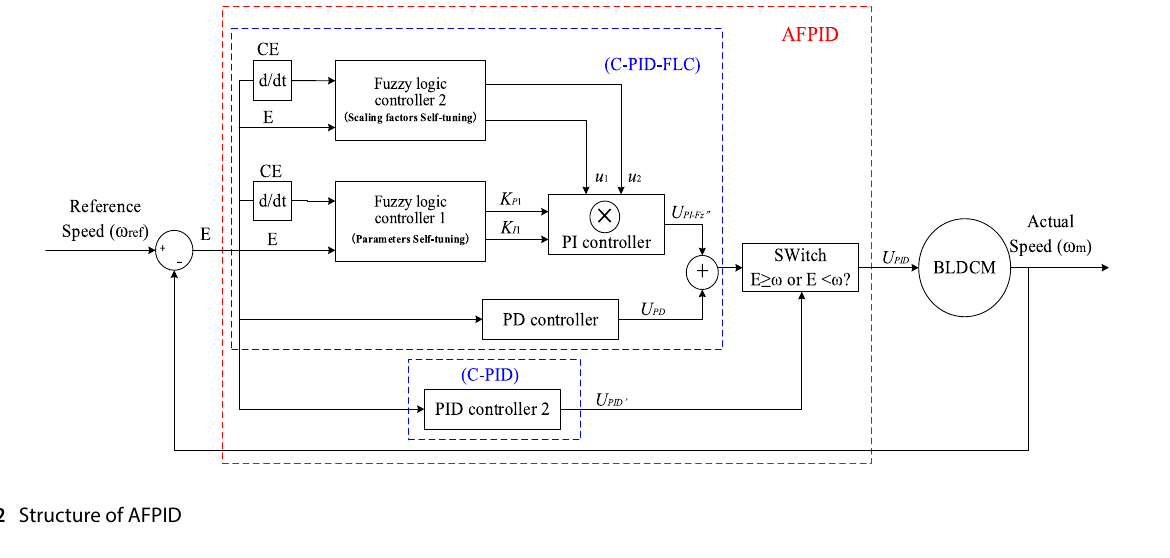
Fig. 2 Structure of